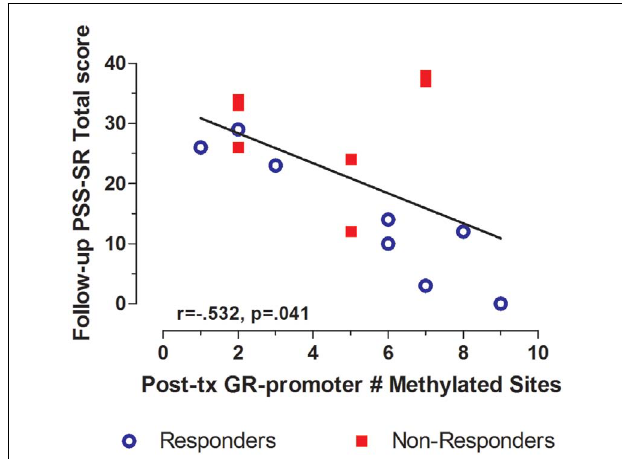
FIGURE 4 | Relationship between GR exon 1F promoter methylation at post-treatment and self-reported PTSD symptom severity at follow-up . Correlations of Post-treatment GR exon 1F promoter methylation (# of methylated sites) with PSS-SR total score at follow-up. Responders ( n = 8) to treatment are represented by blue, open circles and non-responders ( n = 7) by red squares.The higher number of GR exon 1F promoter methylated sites at post-treatment corresponded to a lower PSS-SR total score at follow-up ( r =− 0.532, p = 0.041). Statistical significance was set at p <